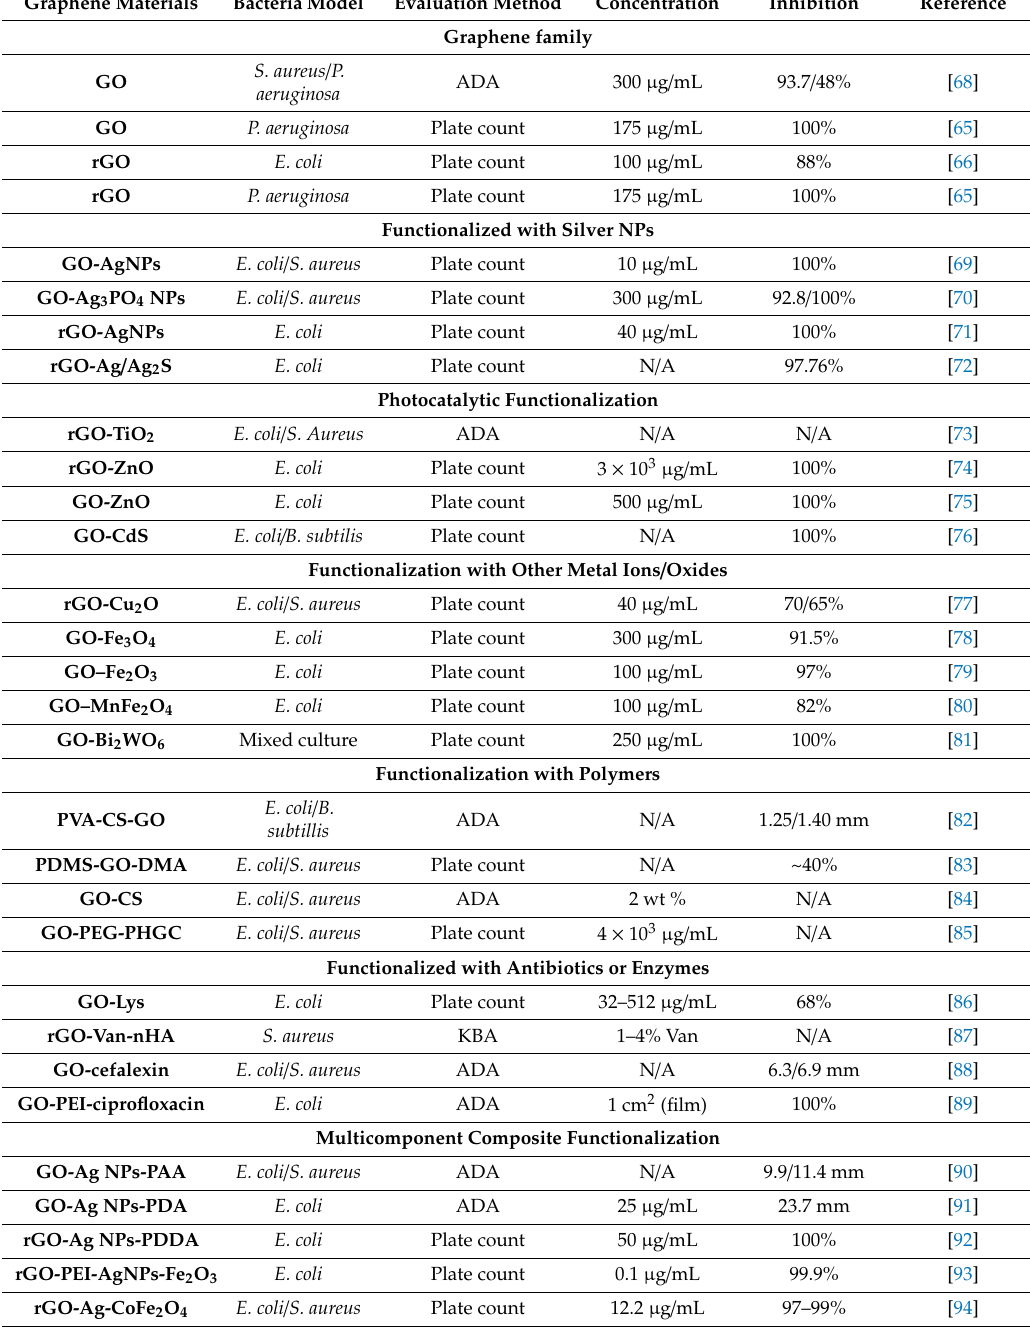
ADA: agar di ff usion assay. CS: chitosan. DMA: dopamine methacrylamide. GO: graphene oxide. Lys: lysozyme. N / A: not applicable. nHA: nano-hydroxylapatite. PAA: poly(acrylic acid). PDA: polydopamine. PDDA: poly (diallyl dimethyl ammonium chloride). PDMS: poly(dimethylsiloxane). PEG: poly (ethylene glycol). PHGC: polyhexamethylene guanidine hydrochloride. PEI: polyethylenimine. PVA: polyvinyl alcohol. Ag: Silver. NPs: Nanoparticles. rGO: reduced graphene oxide. Van: